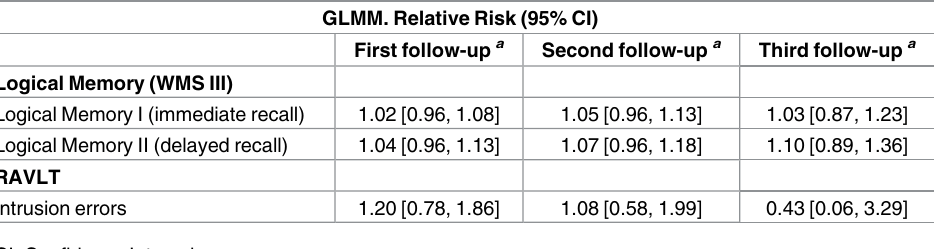
Table 4. Generalized linear mixed models for the progression in performance in stable BDs.